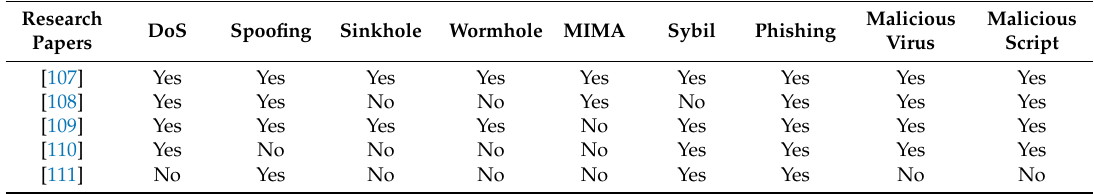
Table 12. Attacks On hybrid security and privacy